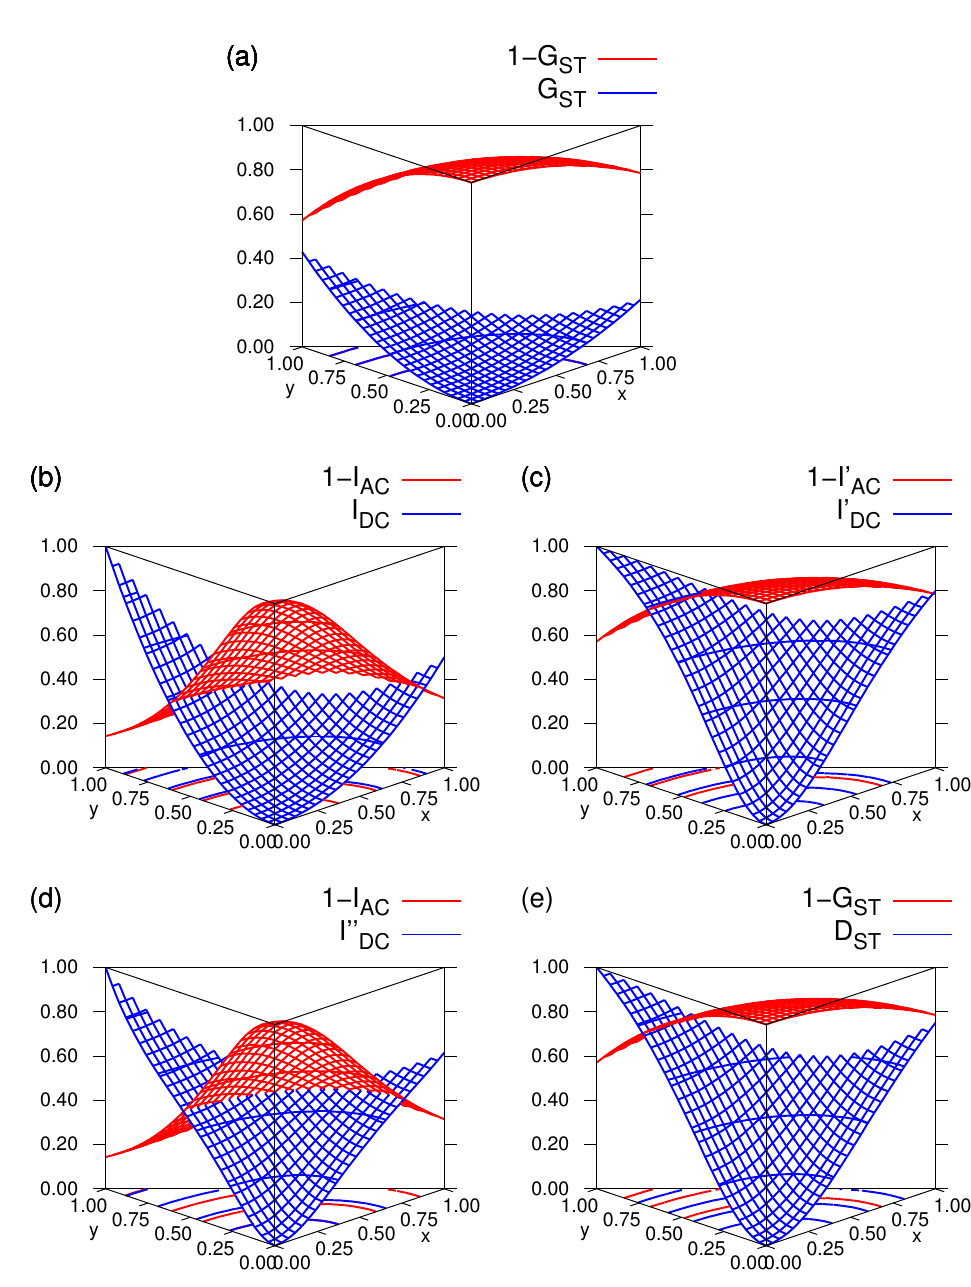
Figure 1. Partitioning of variation within and among communities for joint distributions modeled on the triangle { x + y ≤ 1 } . All plots picture four equally sized communities, eight equally frequent types, and assignment mappings g C ( 1 ) = 1, g C ( 2 ) = 2, g C ( 3 ) = 3, g C ( 4 ) = 4 and g T ( 1 ) = g T ( 2 ) = 1, g T ( 3 ) = g T ( 4 ) = 2, g T ( 5 ) = g T ( 6 ) = 3, g T ( 7 ) = g T ( 8 ) = 4. ( a ) Variation within communities is plotted as 1 − G ST (red surface) together with its inverse G ST (blue surface), which is commonly but erroneously interpreted to measure variation among communities. ( b – e ) Variation within communi- ties measured as 1 min apportionment for indices I A , I (cid:48) , and G ST (red) is plotted against variation A among communities measured by differentiation indices I D , I (cid:48) , I (cid:48)(cid:48) , and D ST (blue). The I -indices D D are calculated with Hill diversity of order 2. Red and blue curves on the base of the triangle are projections of the four contour lines drawn on the respective surfaces at 0.2, 0.4, 0.6, and 0.8 on the vertical